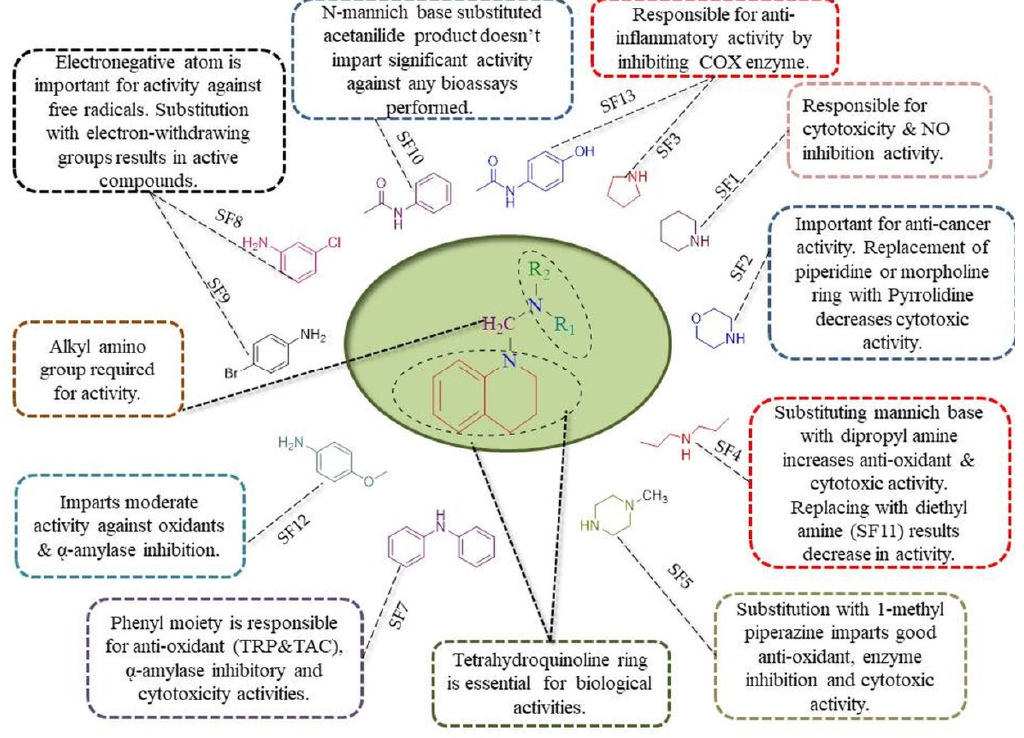
Figure 10. Structure–activity relationship of tetrahydroquinoline ring derivatized with thirteen amines.